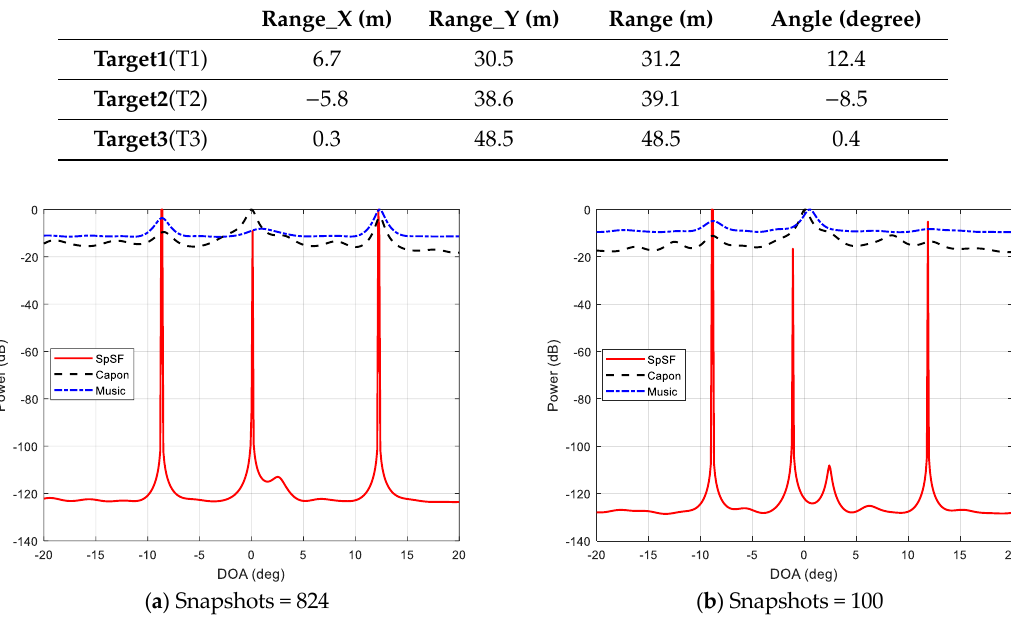
Figure 11. Angle estimation of the real data.